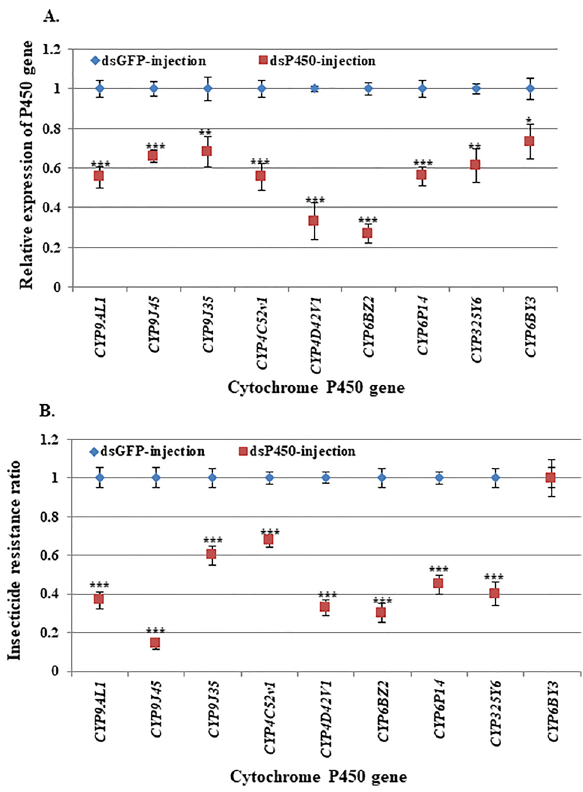
Figure 1. Knockdown of P450 genes associated with permethrin resistance in larvae of Cx. quinquefasciatus . RNAi was conducted in the larvae of the permethrin resistant mosquito strain, HAmCq G8 . DsRNA of P450 and GFP genes were individually injected into 3 rd instar larvae of Culex mosquitoes. ( A ) Gene expression was detected by real-time PCR in 4 th instar larvae, showing significantly decreased expression of P450 genes compared with GFP injection mosquitoes. ( B ) Permethrin sensitivity was determined by larval bioassay, indicating increased susceptibility to permethrin in dsRNA of 9 P450 gene injection mosquitoes compared with GFP-injection ones; the negative control showed no increased susceptibility to permethrin in the dsRNA of non-overexpressed P450 gene injection mosquitoes. The data shown are the mean ± SEM (n ≥ 3). The Student’s t -test was used for significance analysis. *P < 0.05; **P < 0.01; ***P <